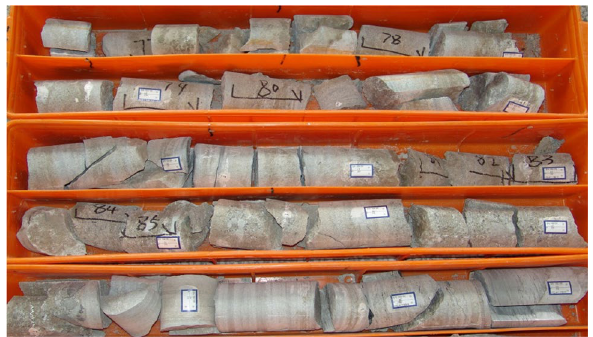
Fig. 2 Bei 14-X56-54 well core